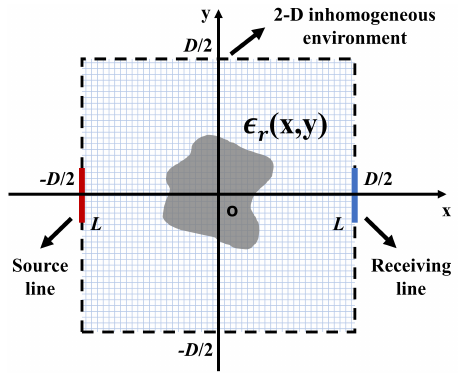
Figure 2. A 2-D inhomogeneous environment for the EDOF analyses. The red and blue lines are the source and receiving lines with the same length L , and 2 L / λ 0 + 1 point sources/receivers (slightly smaller than 0.5 λ 0 spacings, λ 0 is the free-space wavelength) are uniformly distributed along the source/receiving lines for approaching the EDOF limit, and D is the distance between the source and receiving lines. The blue grid represents the discretized grids, and (cid:101) r ( x , y ) characterizes arbitrary isotropic